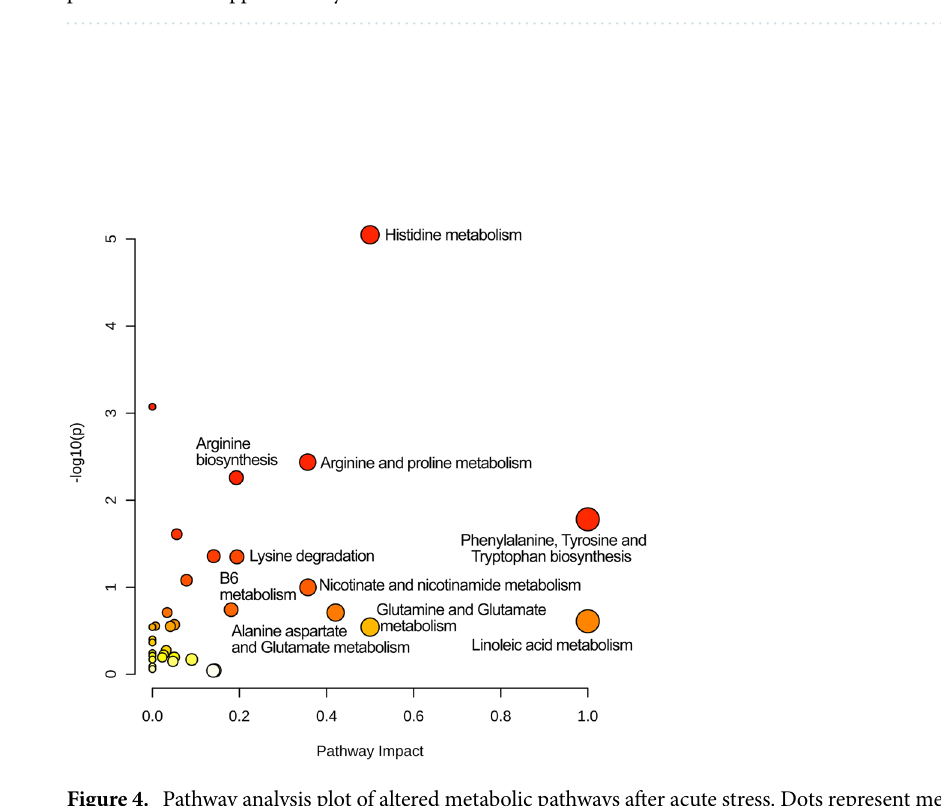
Table 1. Summary of potential biomarkers. Summary of significantly differential metabolite features after acute stress. Metabolites with at least a two-fold change ratio before and after stress were considered differential and Adj P < 0.05 were considered significant. Metabolite features are divided according to their fold-change ratios differences, as well as the assigned level of confidence in the annotation (level 1- match to commercial standards, level 2- full match of the precursor ion and its fragments to online databases (both m/z and MS/ MS), level 3- putative annotation based on precursor ion ( m/z ), level 4- not annotated). Further detail is provided in the supplementary information Table S1.